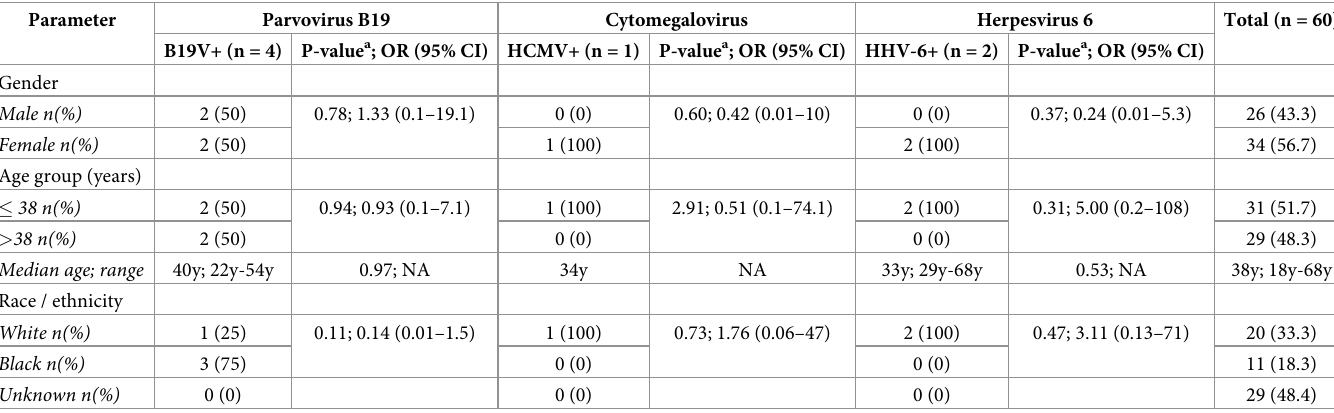
Table 2. Demographical findings among adults with acute febrile illness